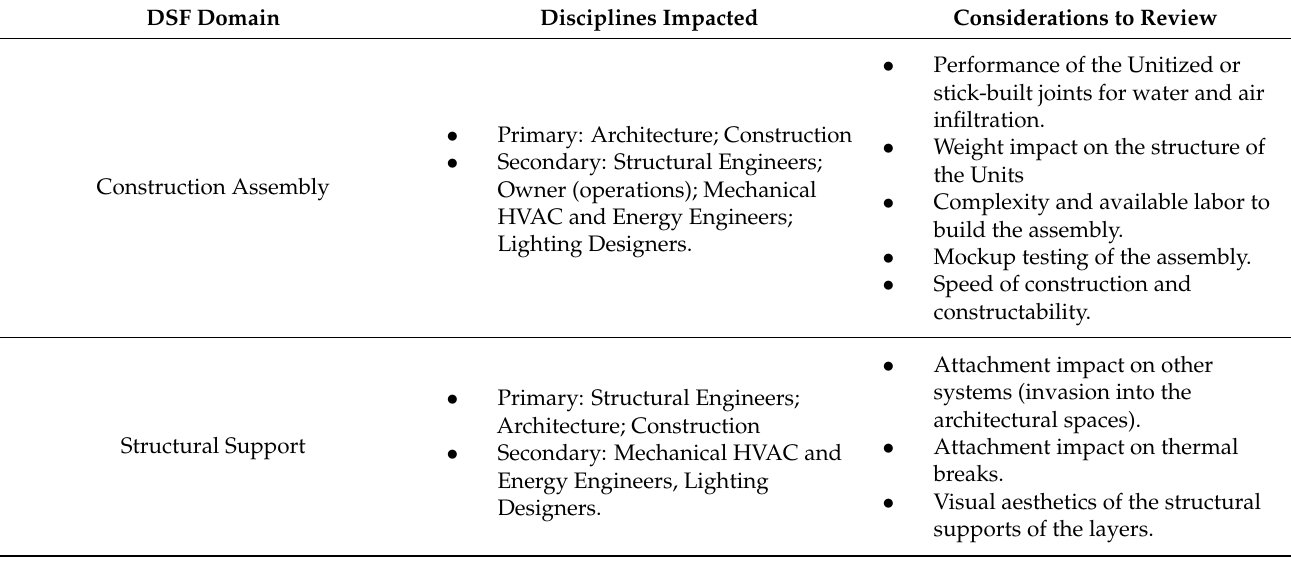
Table 8. Structural and Construction Takeaway cross